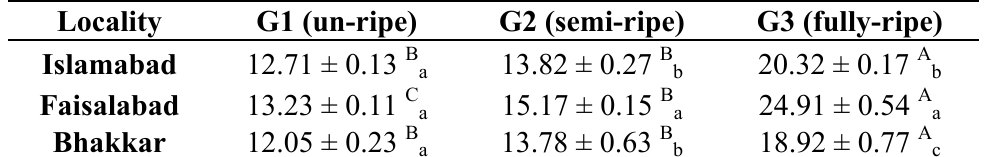
Values are mean ± SD of three samples analyzed individually in triplicate; Superscripts within the same row represent significant variation ( p < 0.05) among ripening stages; Subscripts within the same column represent significant variation ( p < 0.05) among